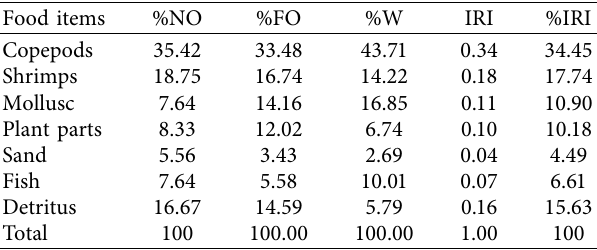
Table 3: Percentage composition of various food items consumed by Heterotis niloticus .